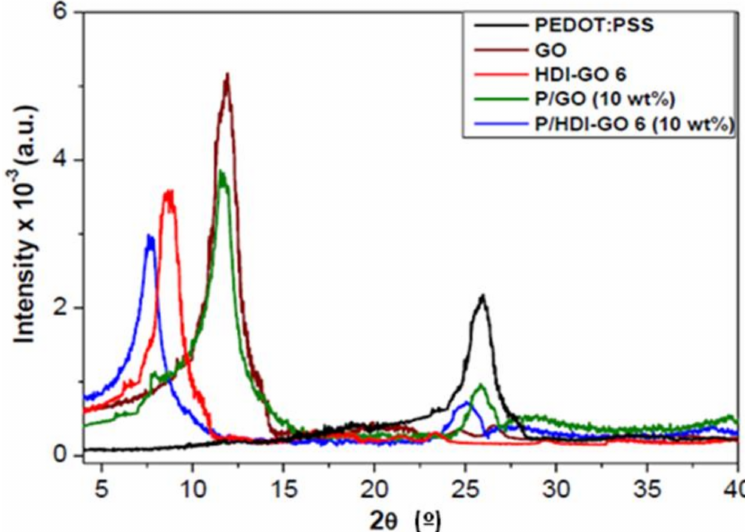
Figure 3. XRD patterns of neat PEDOT:PSS, raw GO, HDI-GO 6, and the corresponding nanocomposites with 10 wt % nanofiller